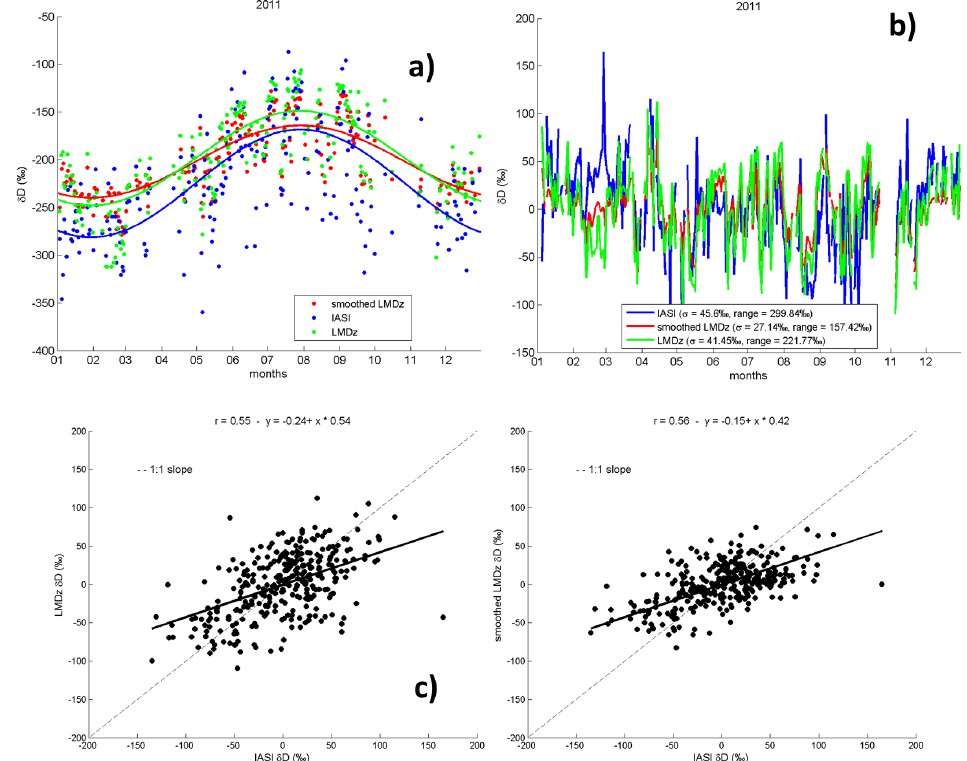
Figure 11. As Fig. 10, for [1–5km] with a | 1T | <